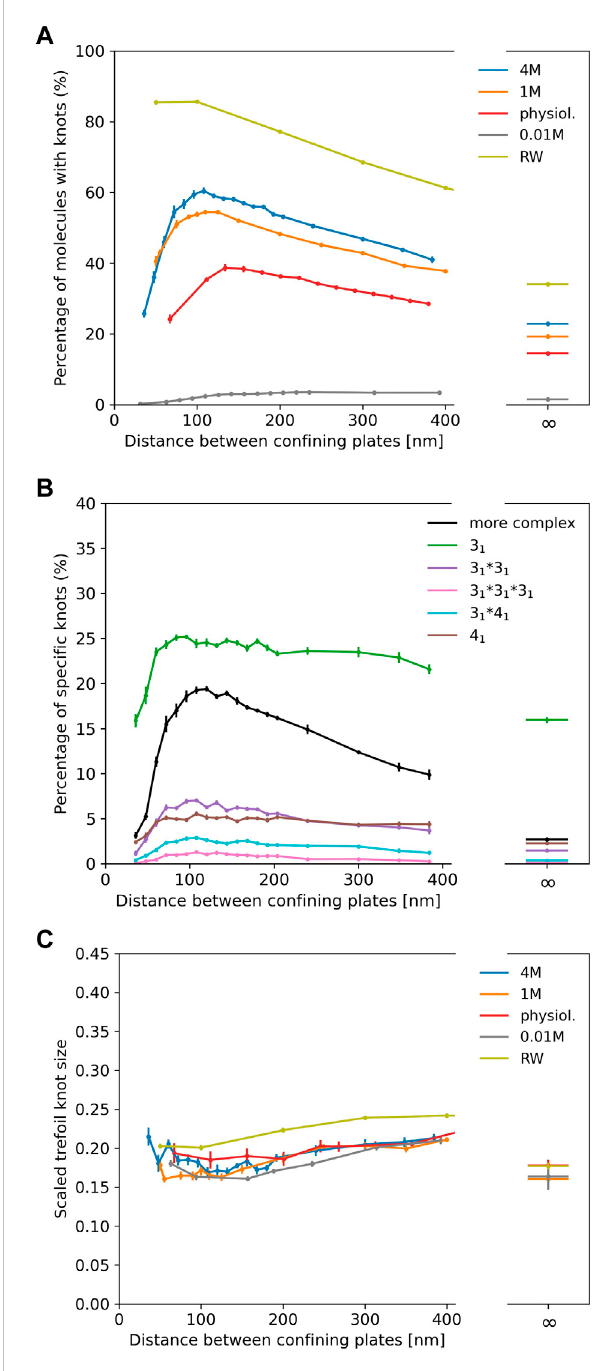
FIGURE 3 (A) Knotting probability of λ phage DNA (48.5 kbp) as a function of plate distance at various ionic conditions in slit-pore con fi nement. (B) Knotspectrumforasaltconcentrationof4 M.Complex knotsrefertoall other knots not listed here excluding the unknot. (C) Average sizes of trefoil